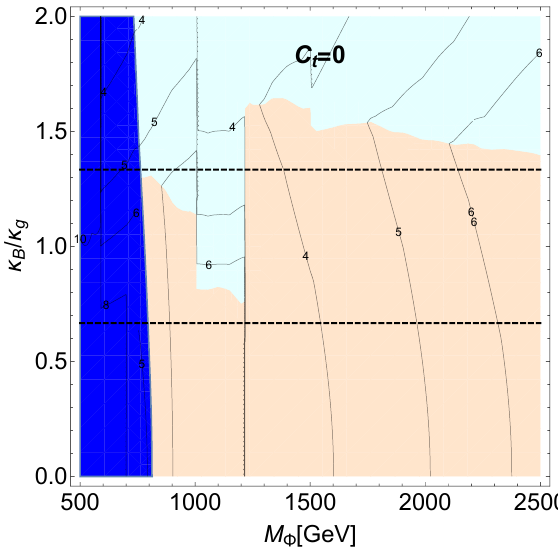
Figure 5 . Expected bounds on color octet single production in the M (cid:8) vs. (cid:20) B =(cid:20) g plane. The dark blue area is excluded from pair production bounds, while the orange (cyan) area labels where the dominant bound arises from the jj ( j(cid:13) ) searches. Contours show the upper bound on (cid:20) g =f (cid:8) in TeV (cid:0) 1 . For reference, the horizontal dashed lines indicate (cid:12)xed (cid:20) B =(cid:20) g ratios of 2 = 3 (lower) and 4 = 3